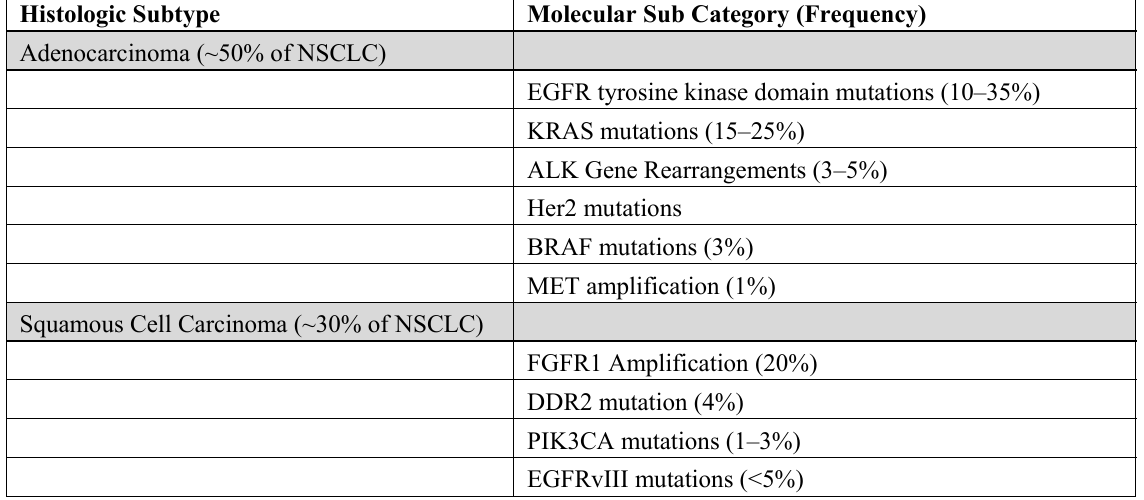
Table 1. Major molecular subtypes of non-small cell lung cancer. Frequency of molecular subtypes are derived from references in the text together with the Catalogue of Somatic Mutations in Cancer (COSMIC) (http://www.sanger.ac.uk/genetics/CGP/cosmic/, accessed on 20 November 2011) and MyCancerGenome.org (http://www.mycancergenome.org/ accessed on 20 November